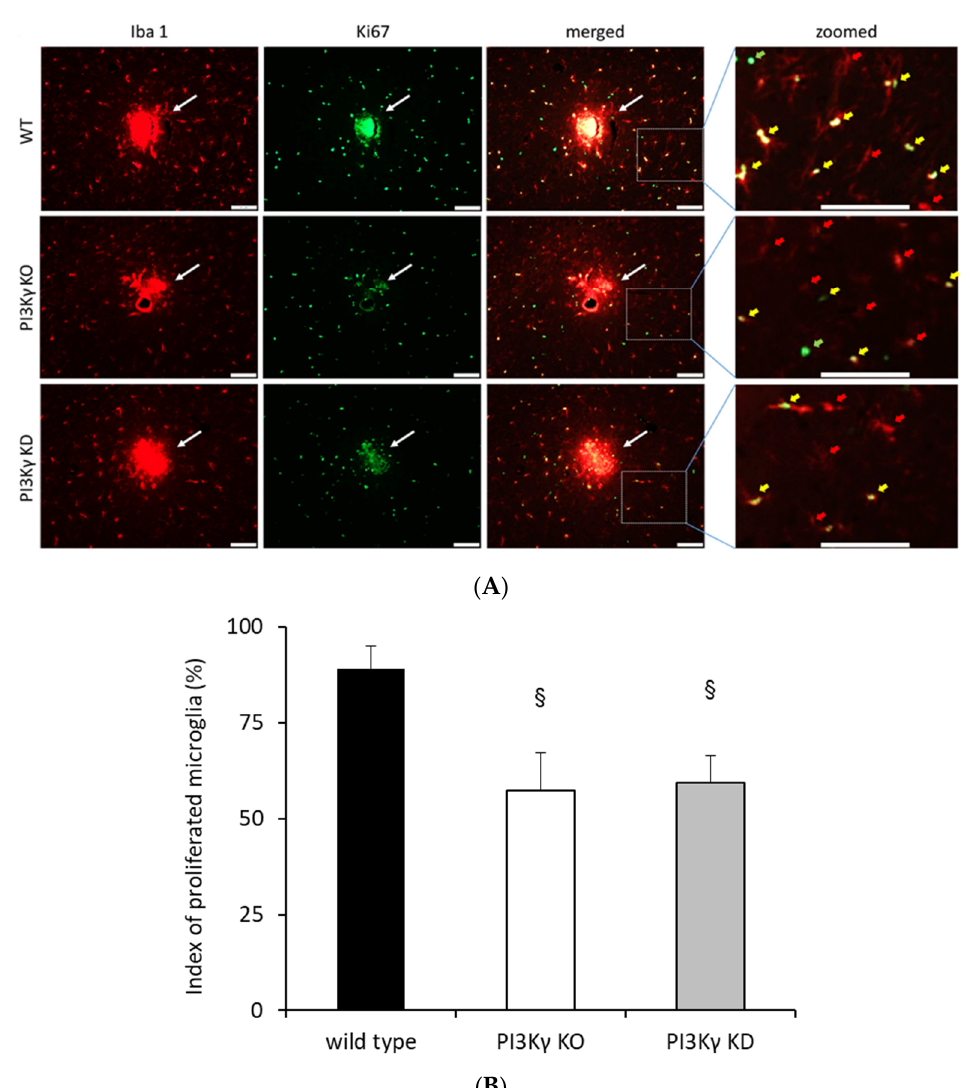
Figure 2. Absence of PI3K γ lipid kinase activity reduces proliferation of microglial cells after brain injury by focal stab damage. ( A ) Representative images of proliferating Iba1-positive cells. Brain slices derived from wild-type (WT), PI3K γ KO and PI3K γ KD mice were co-labeled for Iba1 (cell marker for resident microglia as well as peripheral monocytes/macrophages, red, left panel) and Ki67 (proliferation marker, green, middle panel). Double-positive Iba1/Ki67 microglia show the amount of proliferated microglia (merged/zoomed pictures); yellow arrows: double-positive Iba1/Ki67 cells indicating proliferated microglia; red arrows: Iba1-positive cells indicating resident microglia as well as peripheral monocytes/macrophages; green arrows: Ki67-positive cells, indicating other proliferated cells; white arrows indicate the location of the respective focal wound injury; white asterisks indicate the center of focal stab damage. Bars indicate 100 µm. ( B ) Quantification of proliferating Iba1-positive cells. Proliferation rate of microglia in the brain of wild-type, PI3K γ KO and PI3K γ KD mice. Index of proliferated microglia was determined by the ratio of Iba-1/Ki67- positive cells to total number of Iba1-positive cells. n = 4–5 per group, § p < 0.05, comparison vs. brain slices derived from wild-type mice